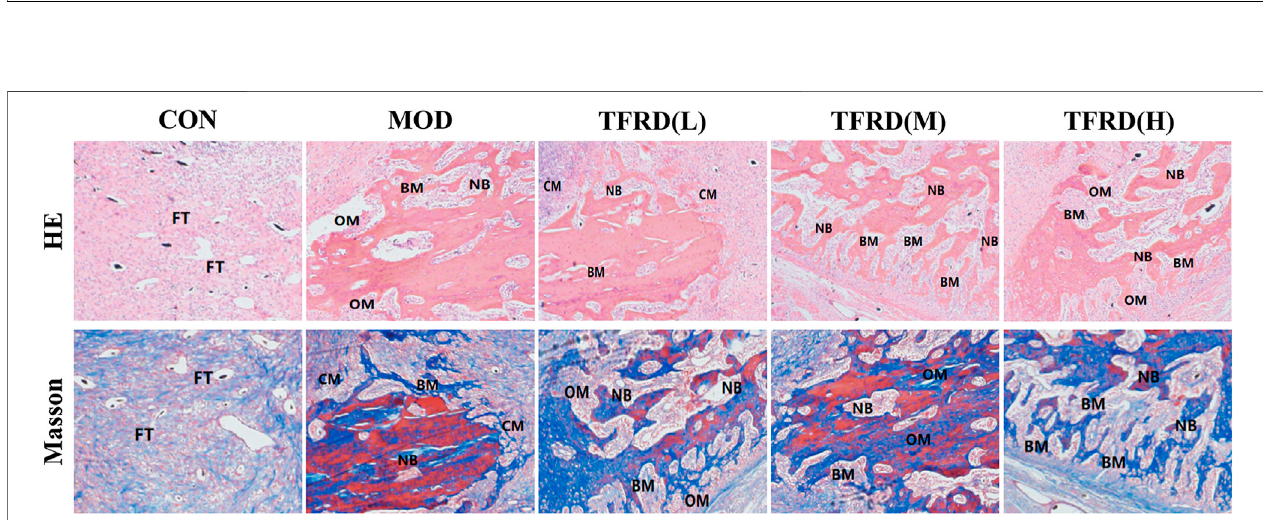
FIGURE 5 | Histological analysis of newly formed tissues within distracted gaps at 12 weeks after surgery. Representative histological images of newly formed tissues within distracted gaps at 12 weeks after surgery ( fi ve random visual fi elds per section, three sections per staining, nine sections per rat). From up to down: H&E, Masson ’ s.Wemainlyobservedsixpointsfromthehistomorphologyassay,includingnewlyformedbone(NB),bonemarrow(BM),osteoidmatrix(OM),chondroidmatrix (CM), and fi brous tissue (FT), to evaluated the bone reconstruction level.